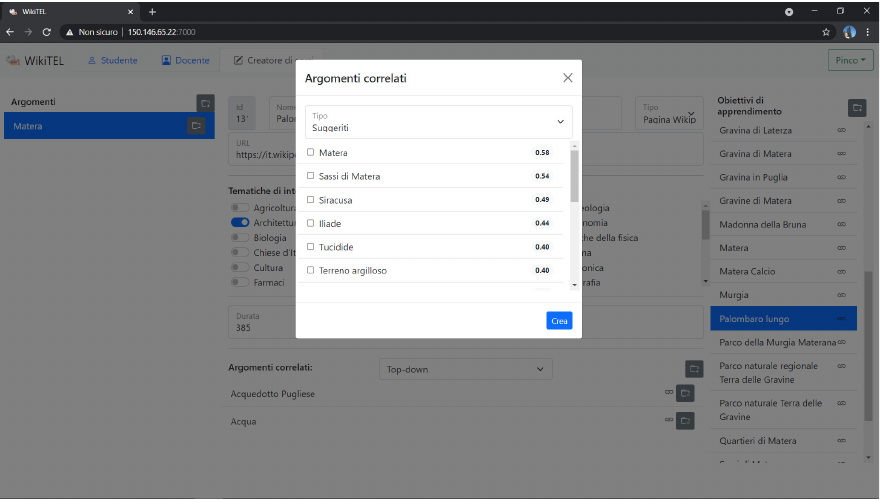
Figure 4. Related topics are sorted according to their relevance.